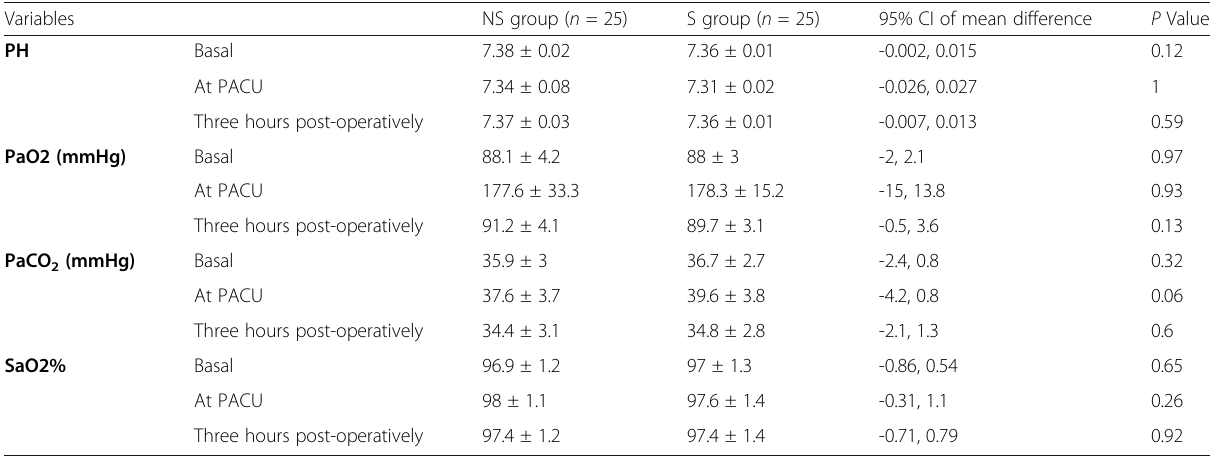
Table 6 Comparison of arterial PH, Oxygen saturation Oxygen tension and carbon dioxide tension levels in the studied groups